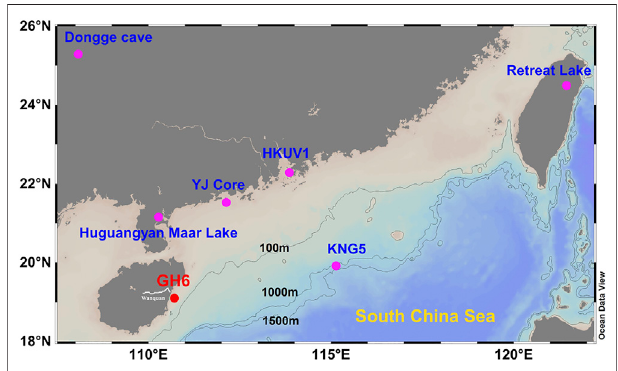
FIGURE 1 | Location map for the GH6 sediment core retrieved from the continental shelf off eastern Hainan Island (red dot) and related study sites in the region (purple dots).